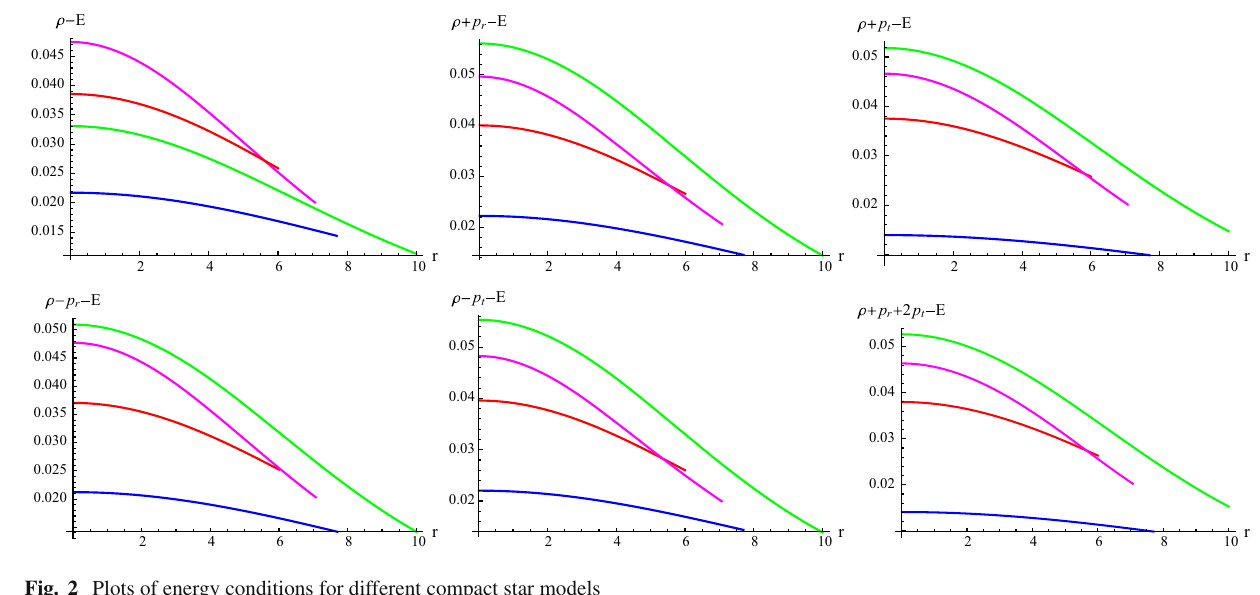
Fig. 2 Plots of energy conditions for different compact star models